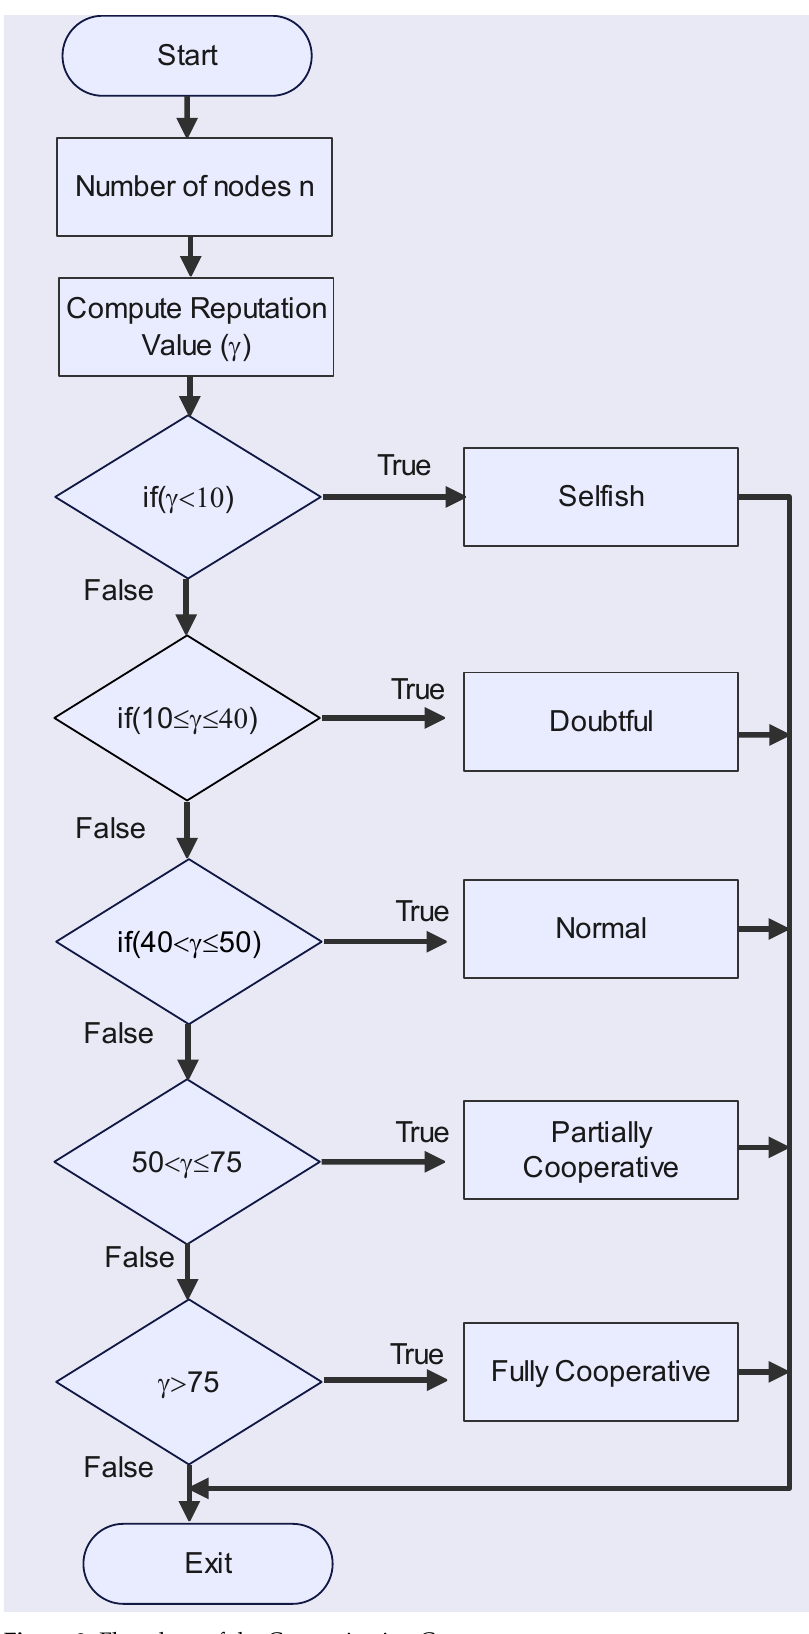
Figure 3. Flowchart of the Categorization